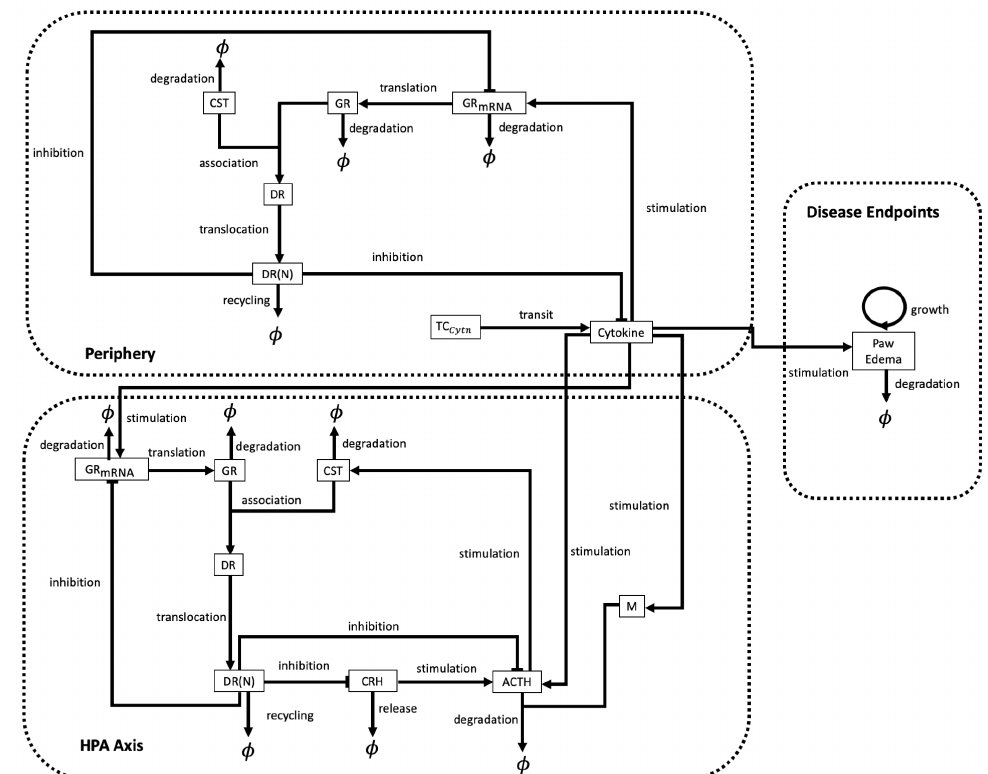
Figure 6. Schematic describing the chemicals and processes included in model described in [47]. The model consists of multiple compartments, and considers the interactions between components within the same compartment and across the compartments. The abbreviations used are; corticosterone (CST), adrenocorticotropic hormone (ACTH), corticotropin-releasing hormone (CRH), free glucocorticoid receptor (GR), glucocorticoid receptor mRNA (GRmRNA), cytoplasmic corticosterone-bound GR (DR), nuclear corticosterone-bound GR (DR(N)), tolerance mediator (M) and cytokine transit compartment (TCCytn). Note that, here φ represents objects removed from the